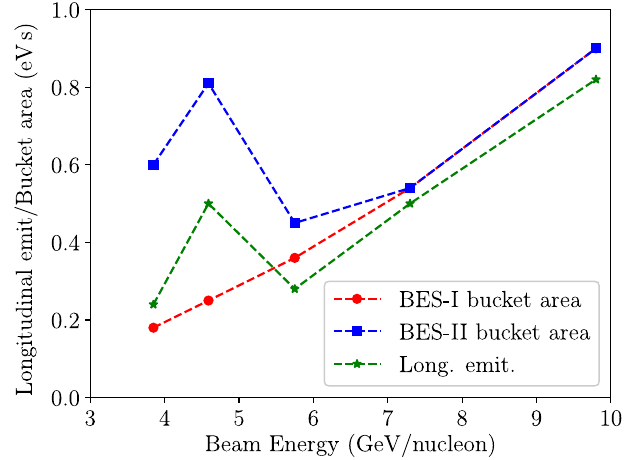
FIG. 19. The bucket acceptances achieved by the rf systems during BES-I and BES-II and the longitudinal emittance of bunches coming out of the AGS during